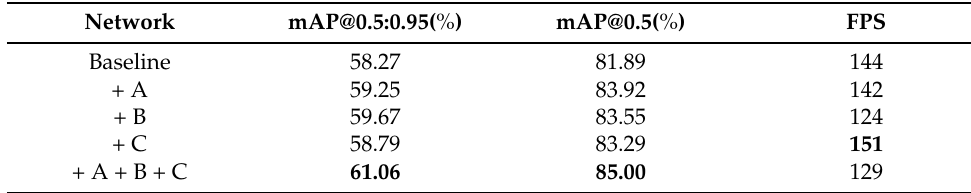
Table 5. Results of ablation experiments in the NRSD dataset.